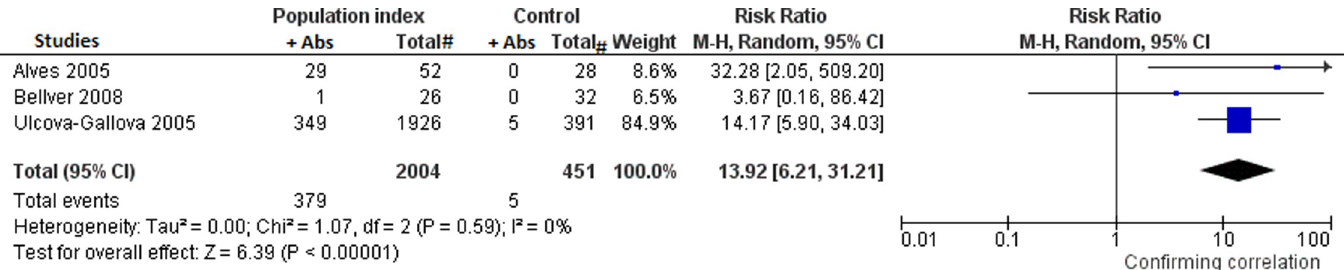
Fig 5. Meta-analysis assessing the risk for implantation failure in relation to the presence or not of anti-PL antibodies in the studies in subgroup B between women with at least two implantation failures in IVF-ET ( population index ) vs women with at least one successful spontaneous pregnancy or unselected healthy fertile women with no history of IVF-ET ( control ). Fig 5: meta-analysis assessing the risk for implantation failure in relation to the presence or not of anti-CL-IgG antibodies.